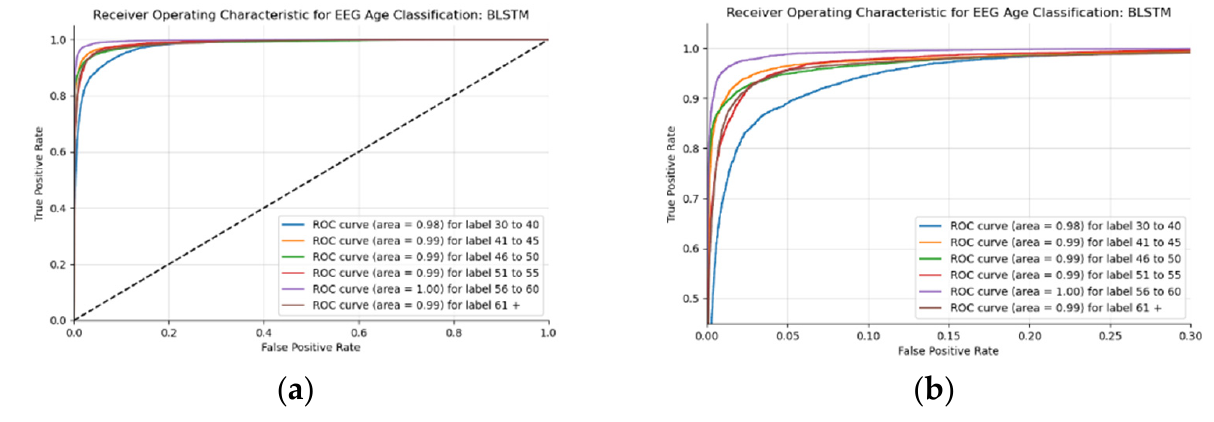
Figure 17. ROC of the utilized BLSTM model on the raw EEG data: ( a ) full ROC figure; ( b ) zoomed